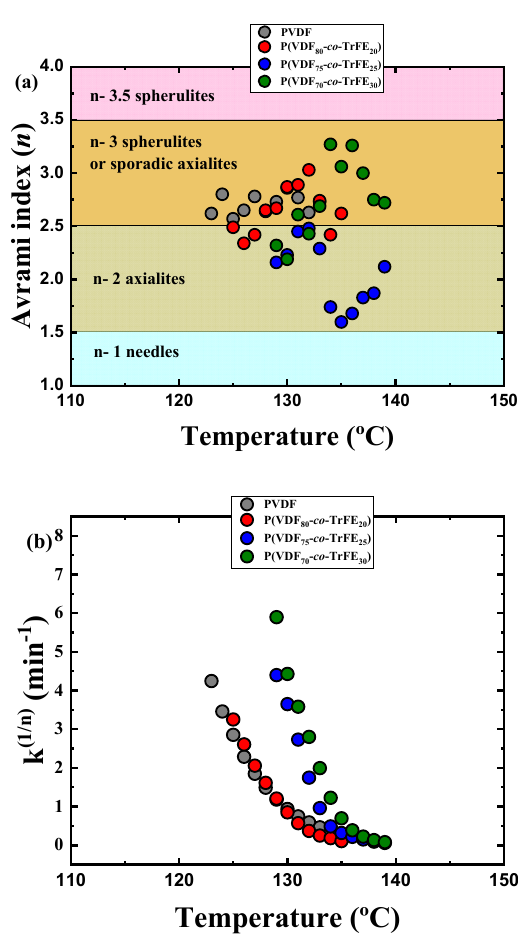
Figure 6. ( a ) Avrami index values for neat PVDF and copolymers at different compositions against their respective isothermal crystallization temperatures and ( b ) crystallization rate obtained by the Avrami model in each isothermal temperature